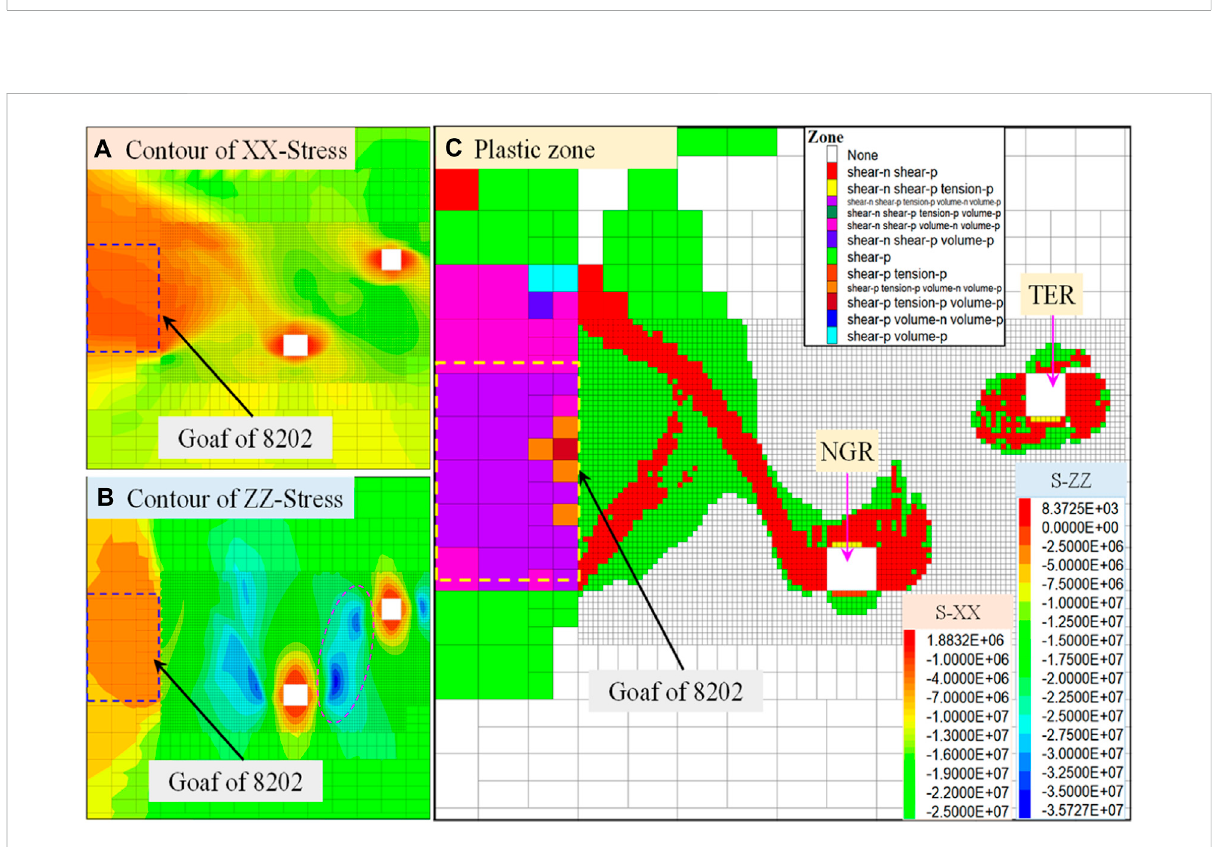
FIGURE 11 Plastic zone and regional stress fi eld distribution of the surrounding rock in TER and